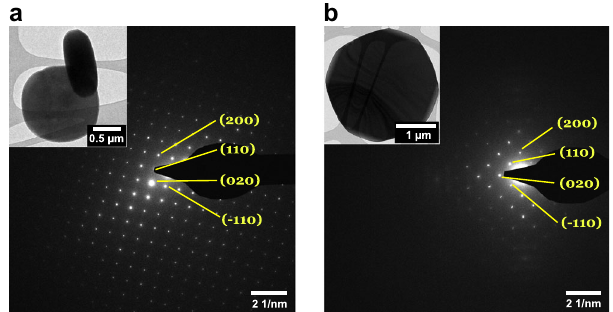
Fig. 1 Crystallinity of as-prepared mixed-ligand MOFs. SAED patterns recorded from an individual particle (BF TEM shown as insets) of as- prepared 5% ( a ) and 50%NH 2 -MIL ( b ). All SAED patterns were indexed using the cif fi le of pure MIL-125-Ti-based MOF 30 viewed along the [001] zone axis with salient re fl ections